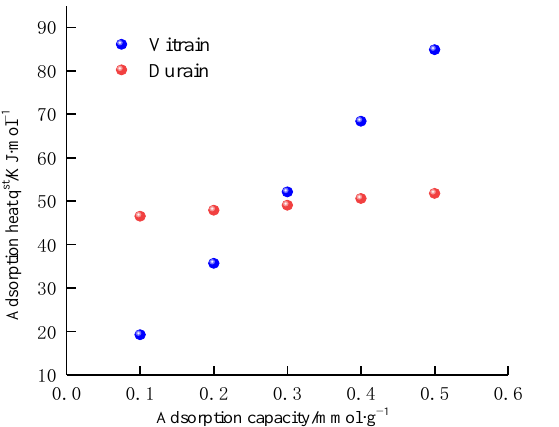
Table 11. Calculation results of the isosteric heat of vitrain and durain samples. Figure 10. The relationship between heat of adsorption and adsorption capacity in the desorption process.